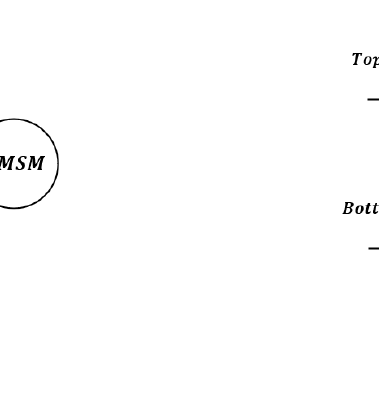
Figure 5. ( a ) VSI (voltage source inverter) configuration block diagram. ( b ) VSI each phase power switch configuration diagram.